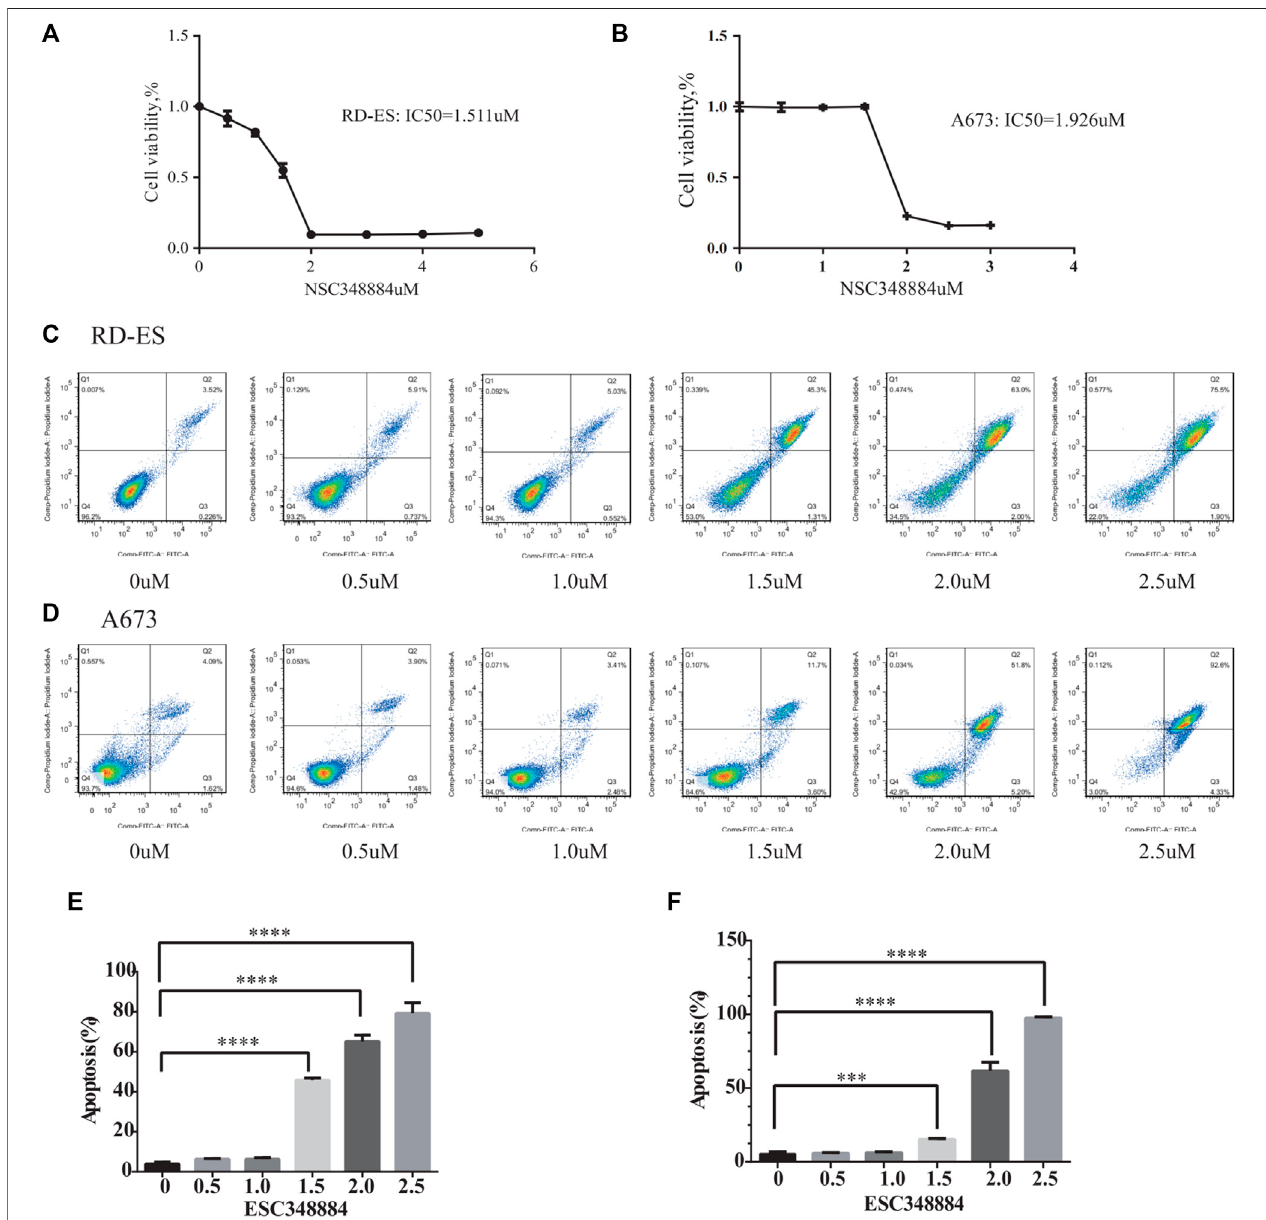
FIGURE 8 | Effect of NSC348884 on the survival rate and apoptosis of RD-ES and A673 cells. (A) Survival rate of RD-ES stimulated by different inhibitor concentrations. (B) Survival rate of A673 cells stimulated by different inhibitor concentrations. (C) Apoptosis rate of RD-ES cells stimulated under six different concentrations, from left to right were 0, 0.5, 1, 1.5, 2, and 2.5 µM. (D) Apoptosis rate of A673 cells stimulated under six different concentrations of ion, from left to right were 0, 0.5, 1, 1.5, 2, and 2.5 µM. (E) The bar graph shows the apoptosis rate of RD-ES cells at different drug concentrations. (F) The bar graph shows the apoptosis rate of A673 cells at different drug concentrations (NA, p > 0.05; *, p < 0.05; **, p < 0.01; ***, p < 0.001; ****, p <